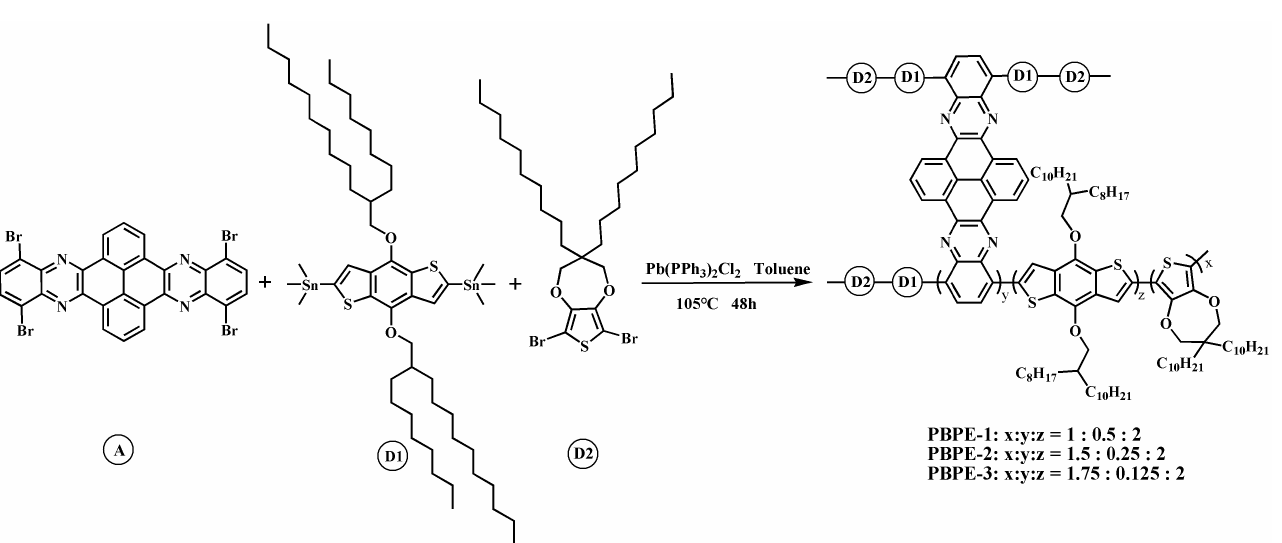
Figure 1. Synthetic routes of PBPE-1, PBPE-2 and